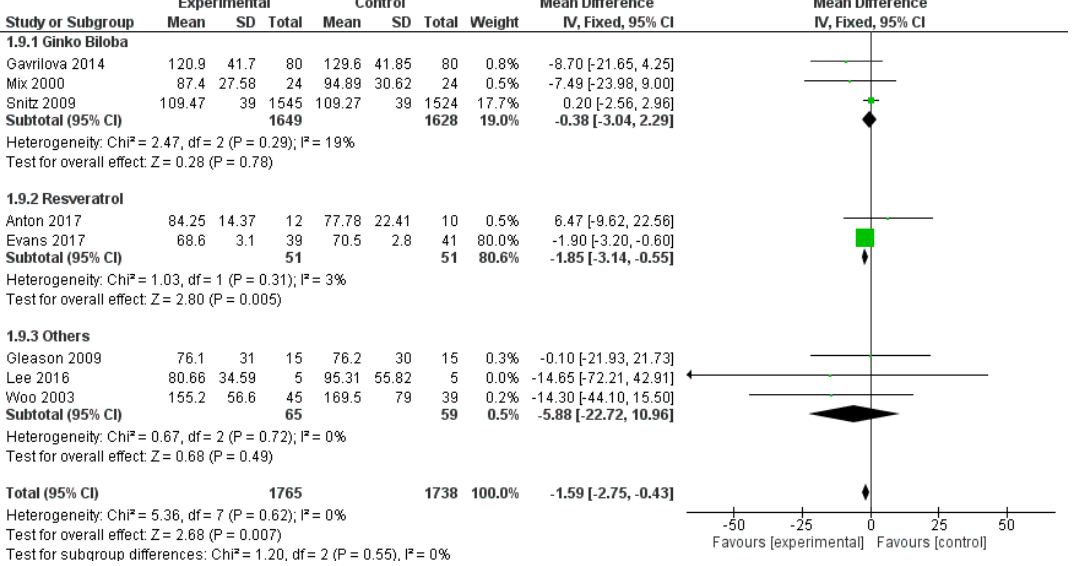
Figure 13. Pooled analysis of the impact of polyphenols on Trail Making Test B.